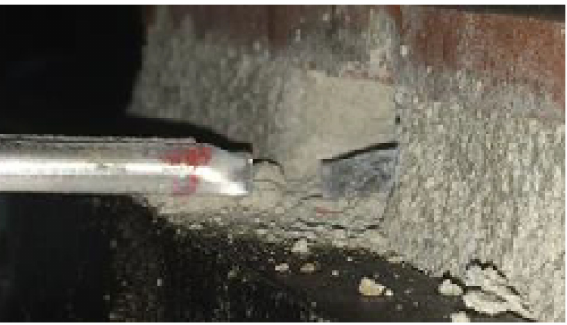
Figure 6. Example of tie connection failure mode observed for the tie type under consideration.